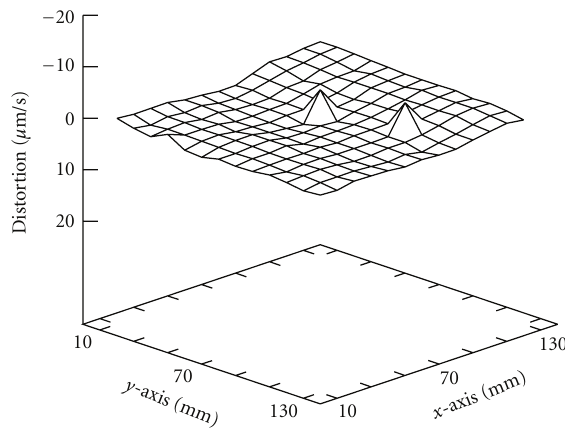
Figure 3: Distribution of press position: the flatness between the mold and the substrate was within 5 μ m, in a 130 × 130 mm 2 area measured by step-and-repeat operation with the nanoimprinting system.